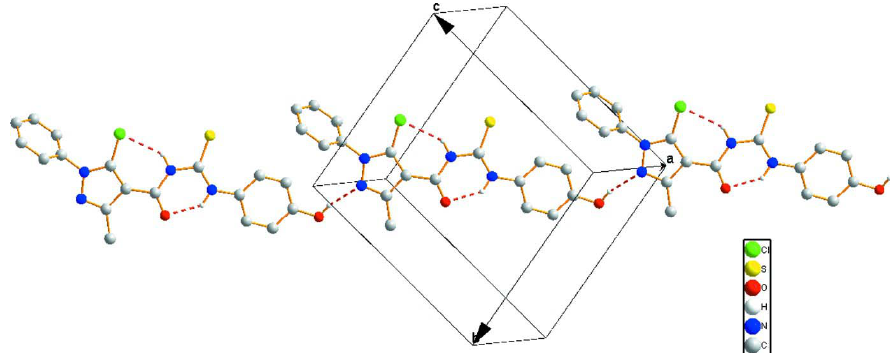
The molecular structure of the title compound with the atom numbering scheme, showing displacement ellipsoids at the 50% probability level.